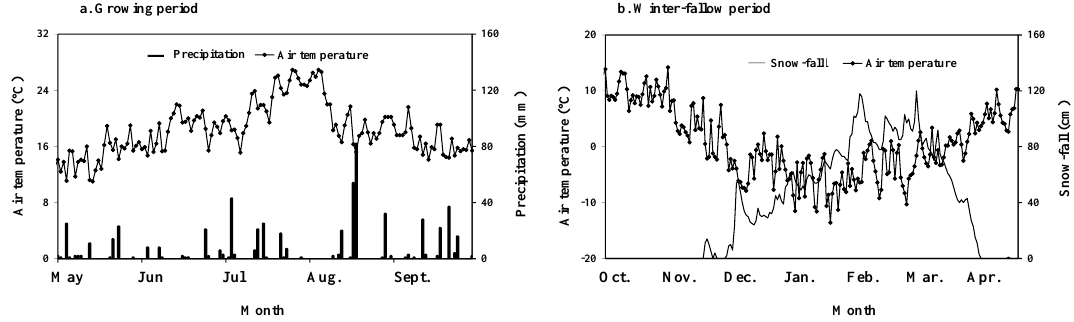
Figure 3. ( a , b ). Climatic conditions of investigated area during rice growing and winter-fallow period.